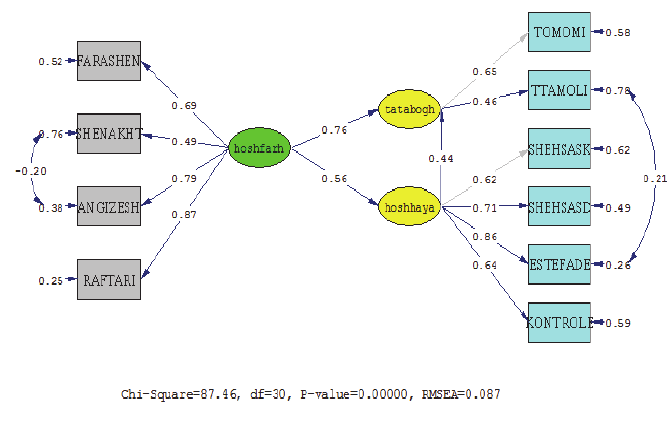
Fig. 3. The results of structural equation